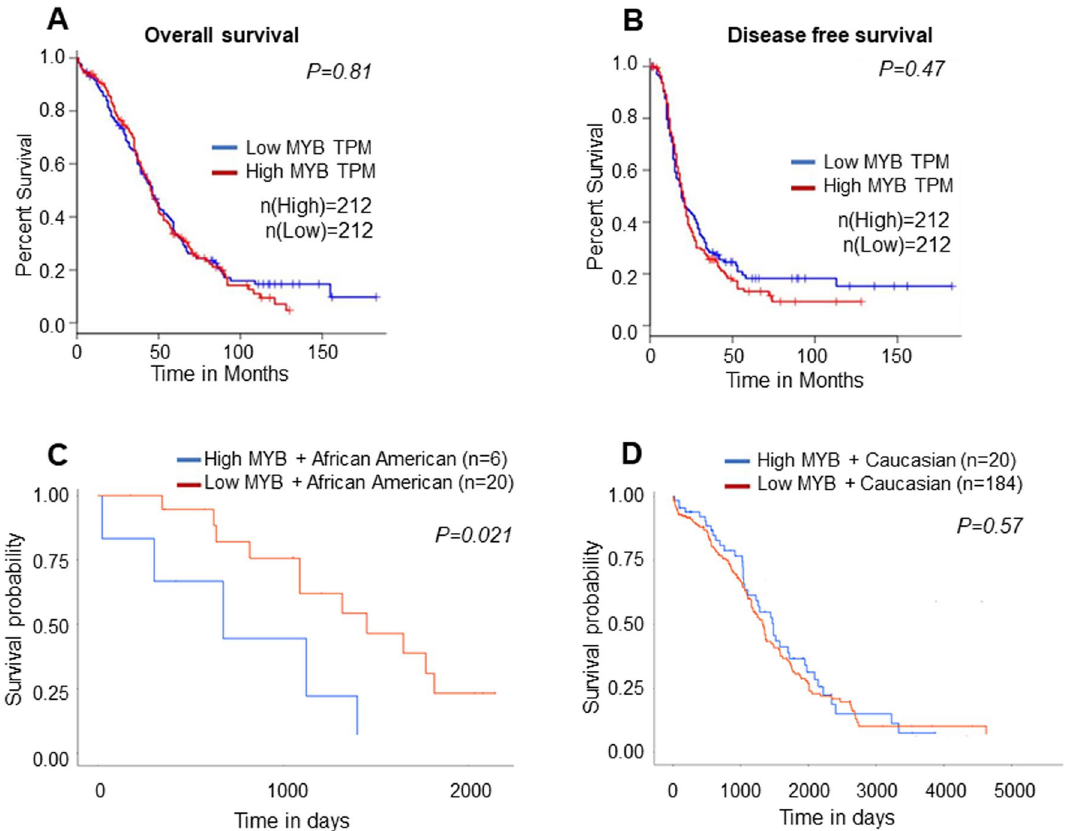
survival. ( C , D ), African American women (n = 26) with high-MYB expression demonstrating poor disease outcome (p = 0.021), but not the Caucasian American (n = 204) (p =